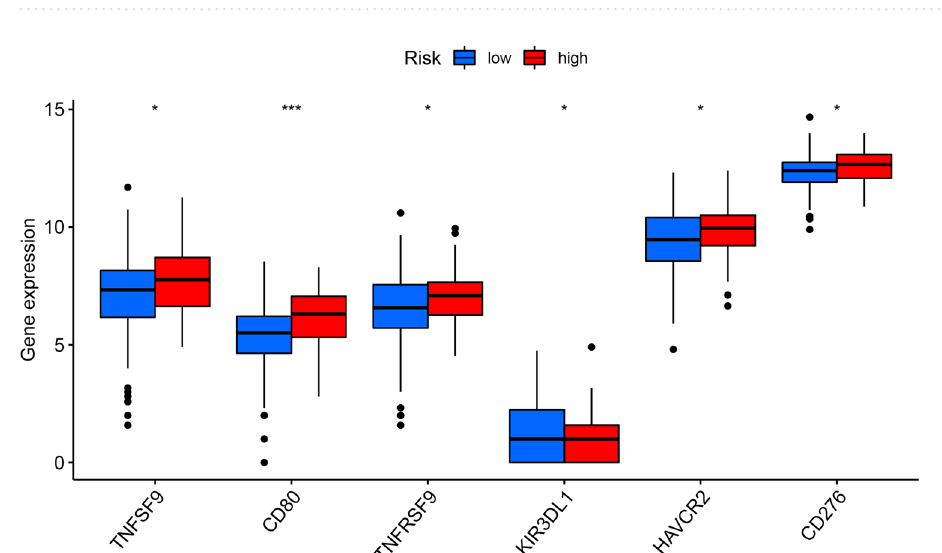
Figure 12. Differences between high and low risk groups in immune